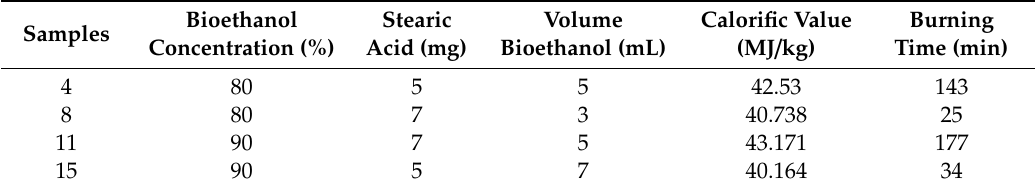
Table 4. Burning time test results for the solid bioethanol with the highest calorific value.